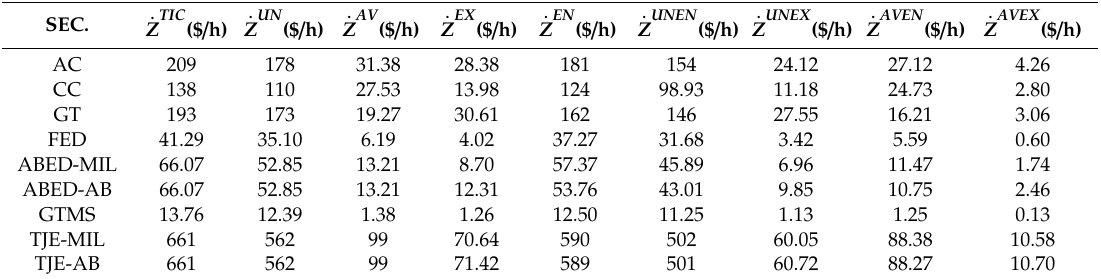
Table 16. Results for advanced investment costs for H 2 utilization.